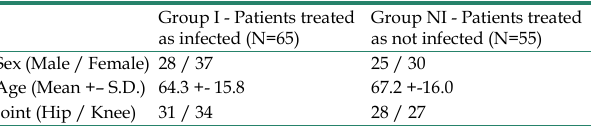
Table 1. Pre-operative data of the population under study. Group I - Patients treated Group NI - Patients treated as infected (N=65) as not infected